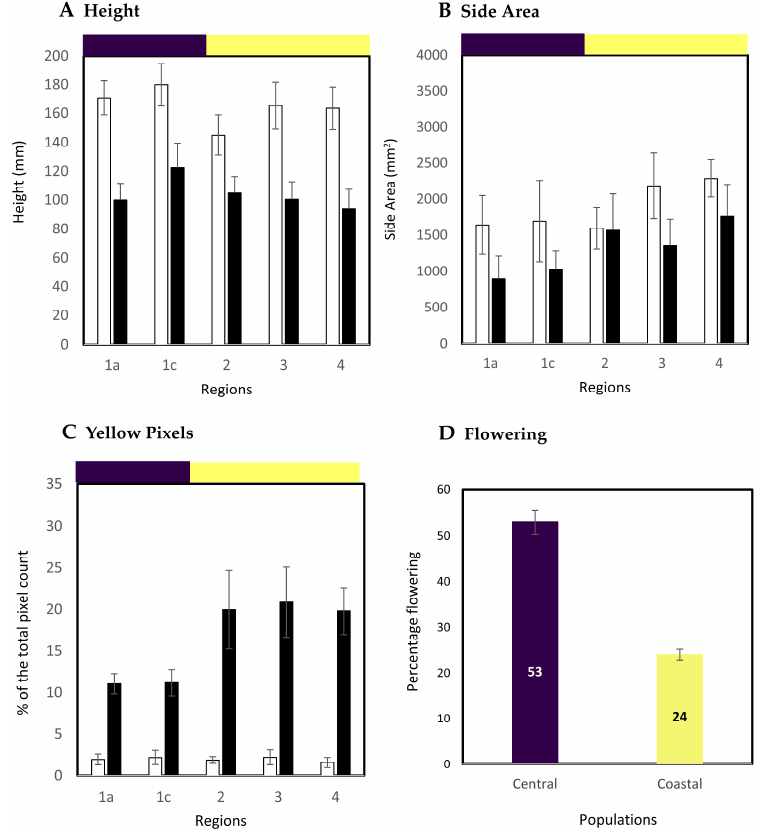
Figure 3. Phenotypic variation in the Turkish collection of Brachypodium. Brachypodium accessions ( n = 8 plants) were vernalized for six weeks at 4 °C before being transferred to 22 °C and either maintained with full watering ( n = 4 plants, white bars) or at 15% soil water content ( n = 4 plants, black bars). At 12 d the plants were imaged at the National Plant Phenomics Centre, Aberystwyth, UK, where ( A ) height and ( B ) side area were derived. Data are grouped based on regional origins (1a, 1c, 2, 3, 4); ( C ) yellow pixels were extracted from the images of plants. Pixel data are presented as % of the total pixel count for the whole plant. The purple and yellow horizontal bars on ( A – C ) indicate data from accessions sampled from central (1a, 1c) and coastal (2, 3, 4) subpopulations, respectively; ( D ) after a further eight weeks the percentage of control plants originating from the coastal and central subpopulations which had flowered was measured. Pixel colors were extracted from the images and the percentage of yellow pixels (indicative of stress associated leaf senescence) was significantly less in plants from region 1a and 1c as compared to plants from other regions ( p < 0.001) (Figure 3C). In our previous publication we associated yellow pixel percentage with the extend of tolerance to stress [6]. This indicated a difference between the coastal and central subpopulation in terms of responses to drought stress with the central being more